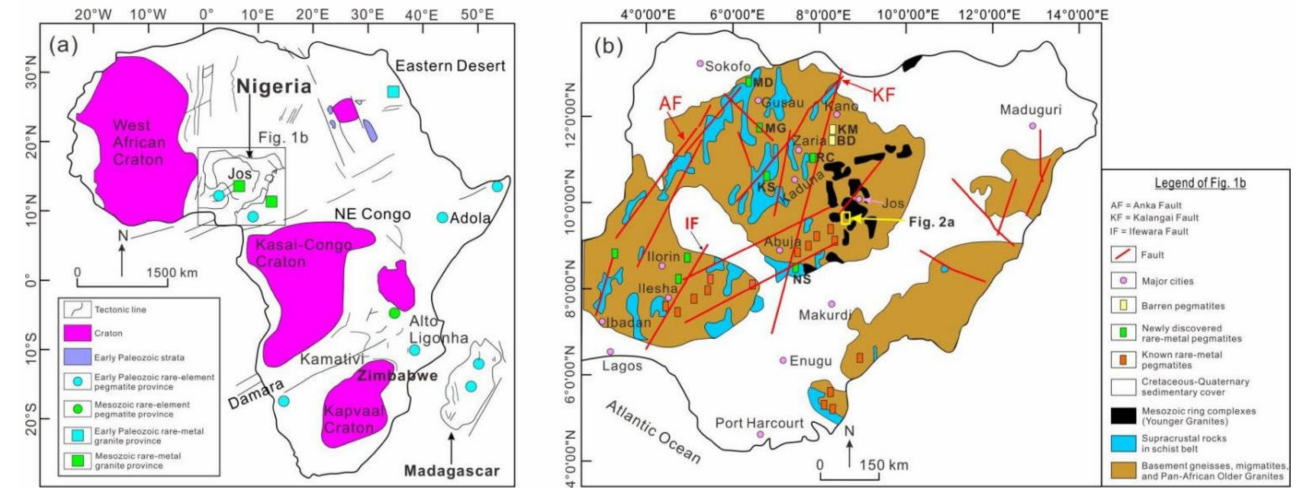
Figure 1. ( a ) Geological sketch map of African rare-element pegmatite and rare-metal granite provinces (Modified after [7,11,12]). Colors indicate age provinces. Box shows the location of Nigerian Precambrian suites and Younger Granites in ( b ); ( b ) Regional geological map of the Nigerian Pan-African basement, showing locations of areas of rare-metal and barren